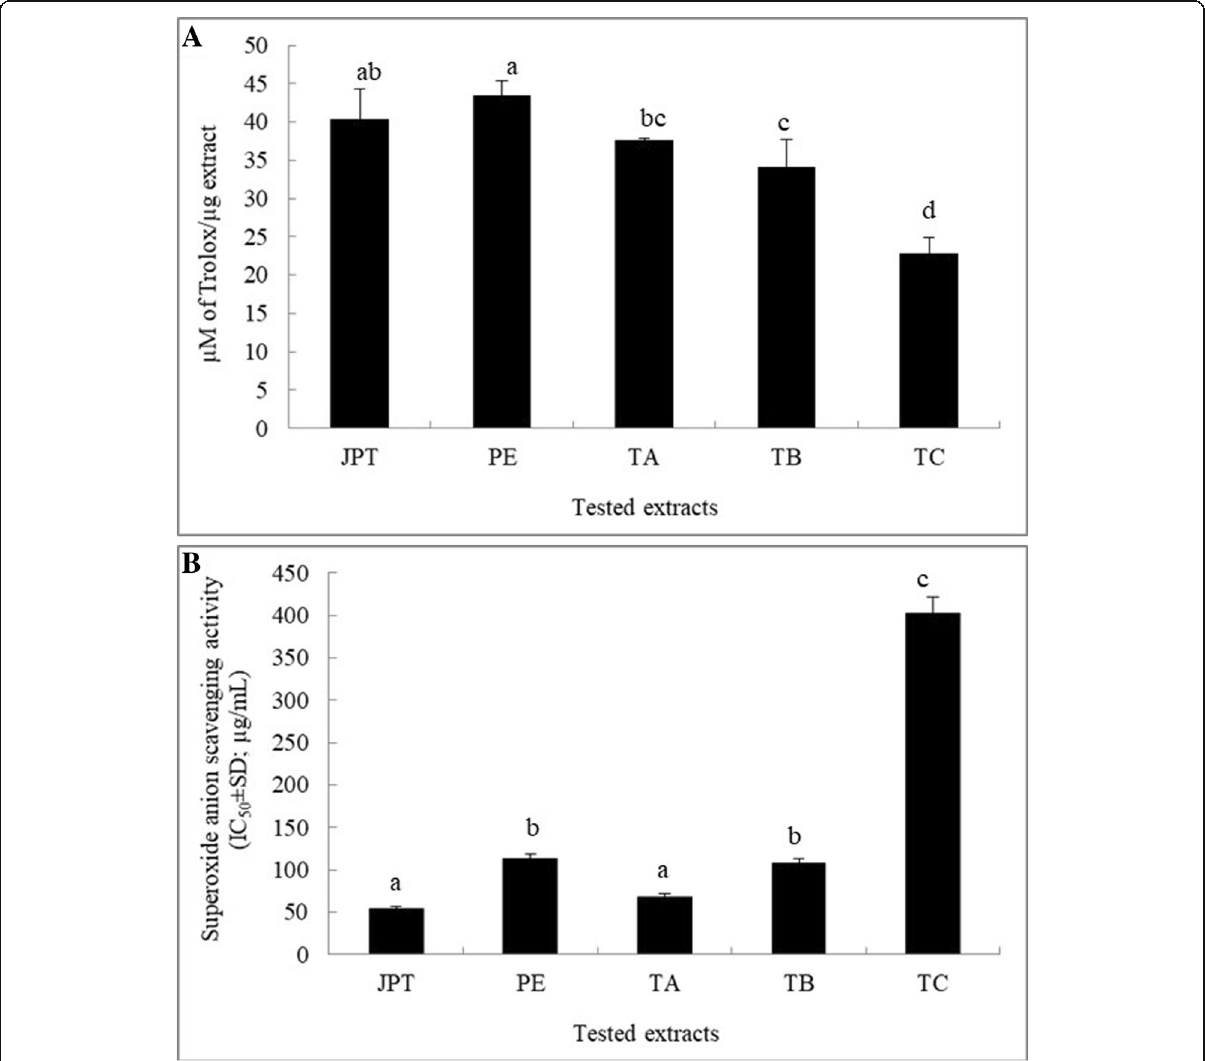
Fig. 2 Effects of Jatu-Phala-Tiga (JPT), Phyllanthus emblica (PE), Terminalia arjuna (TA), Terminalia bellirica (TB), and Terminalia chebula (TC) water extracts on production of peroxyl radicals ( a ) and superoxide anion radicals ( b ). All values are presented as the means± SD. Bars with different letters indicate statistically significant differences among groups at p < 0.05 by one-way